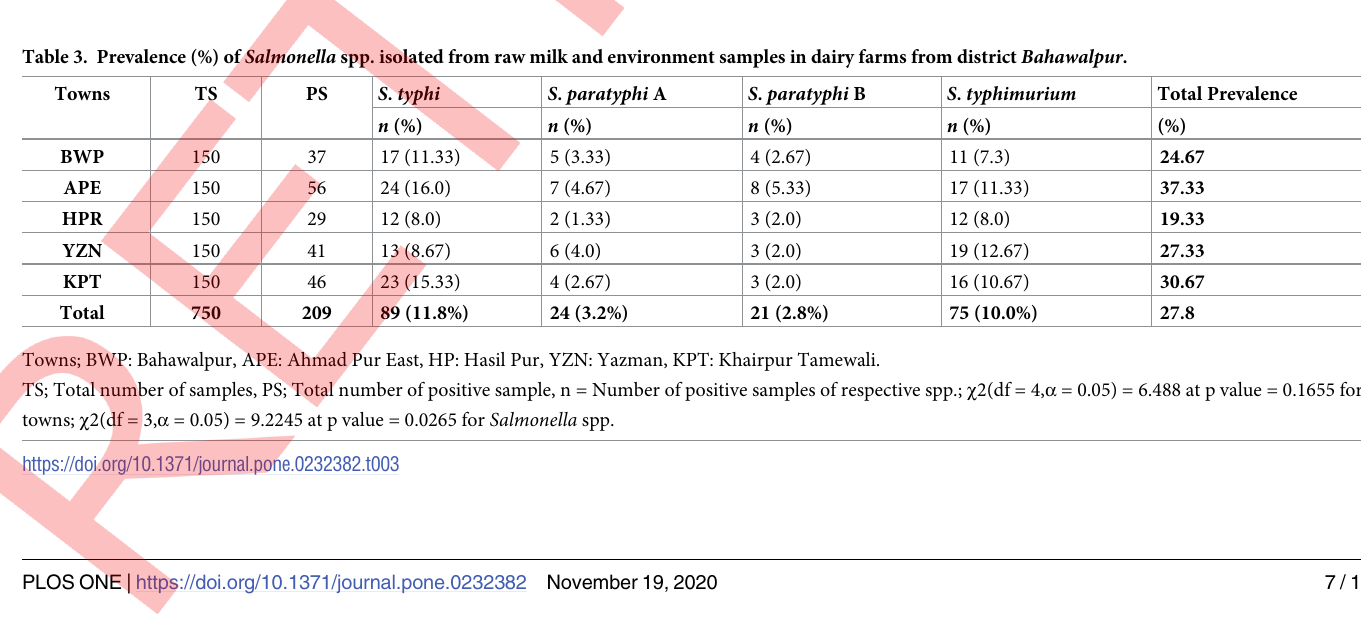
(Table 4). Considering the extent of Salmonella spp. contamination in different towns, com- parative results for prevalence (%) of Salmonella spp. revealed that the environment of sites from district Dunya Pur , was the most polluted with S . typhi (11.33%) and S . typhimurium (9.33%) both being more prevalent as compared to other Salmonella spp. (Table 4). S . typhi was found to be the most prevalent (11.0%) strain followed by S . typhimurium (10.33%) from D . G . Khan and Taunsa Sharif (Table 5). Town wise total percentage of